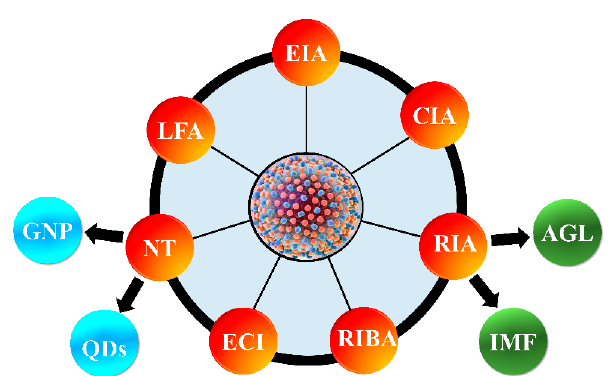
Figure 2. Algorithm for Hepatitis C screening.